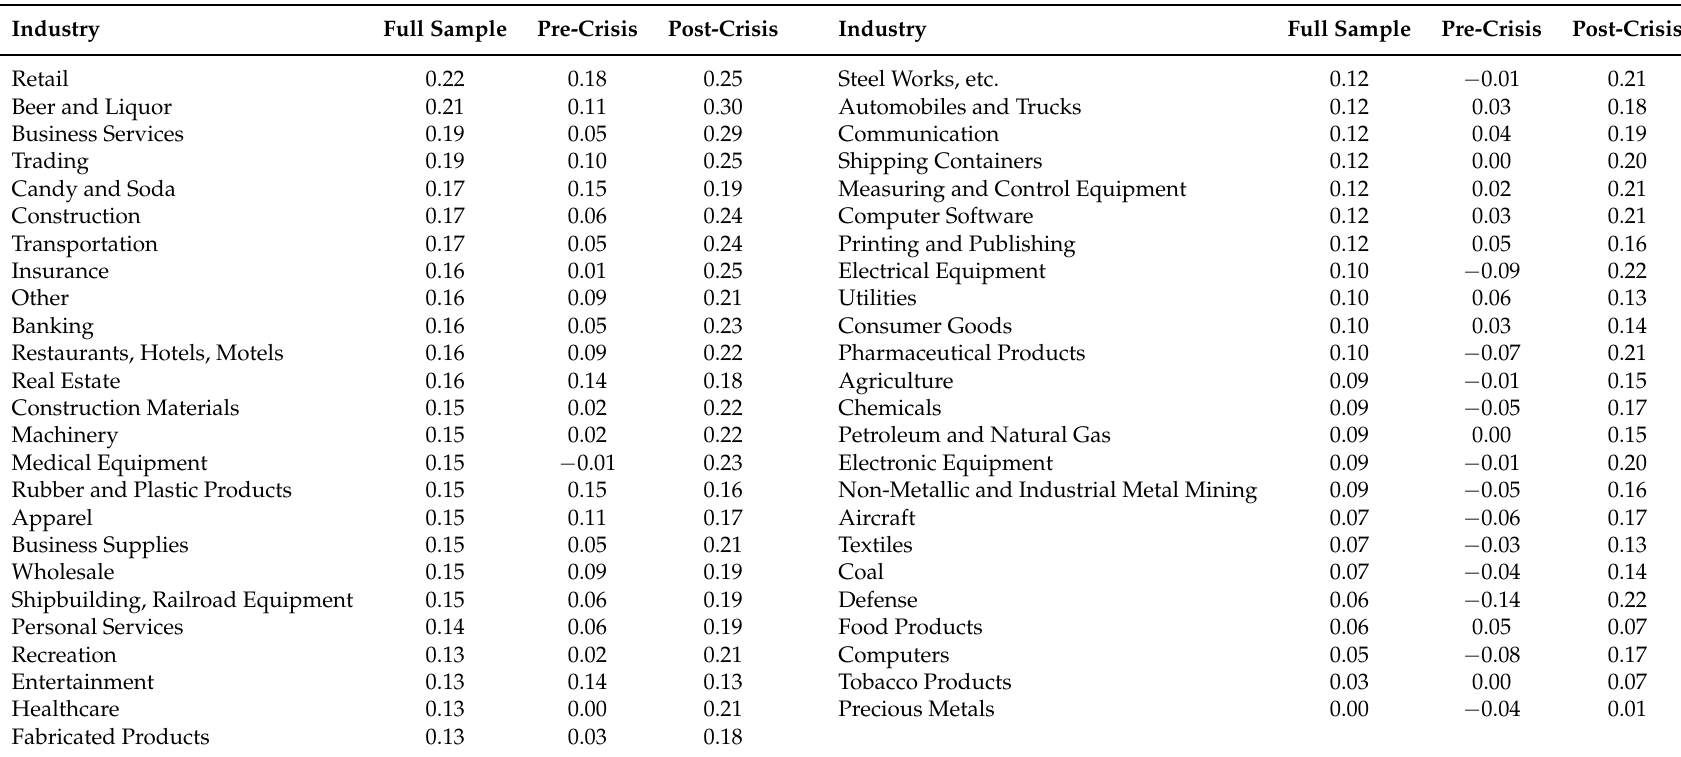
Table A4. The table reports the Pearson correlation between the post-war art index and each of the Fama and French 49 industry groups over three time periods. Full sample refers to correlations computed using monthly data ranging from 2002:04 to 2017:09; pre-crisis correlations are computed using data ranging from 2002:04